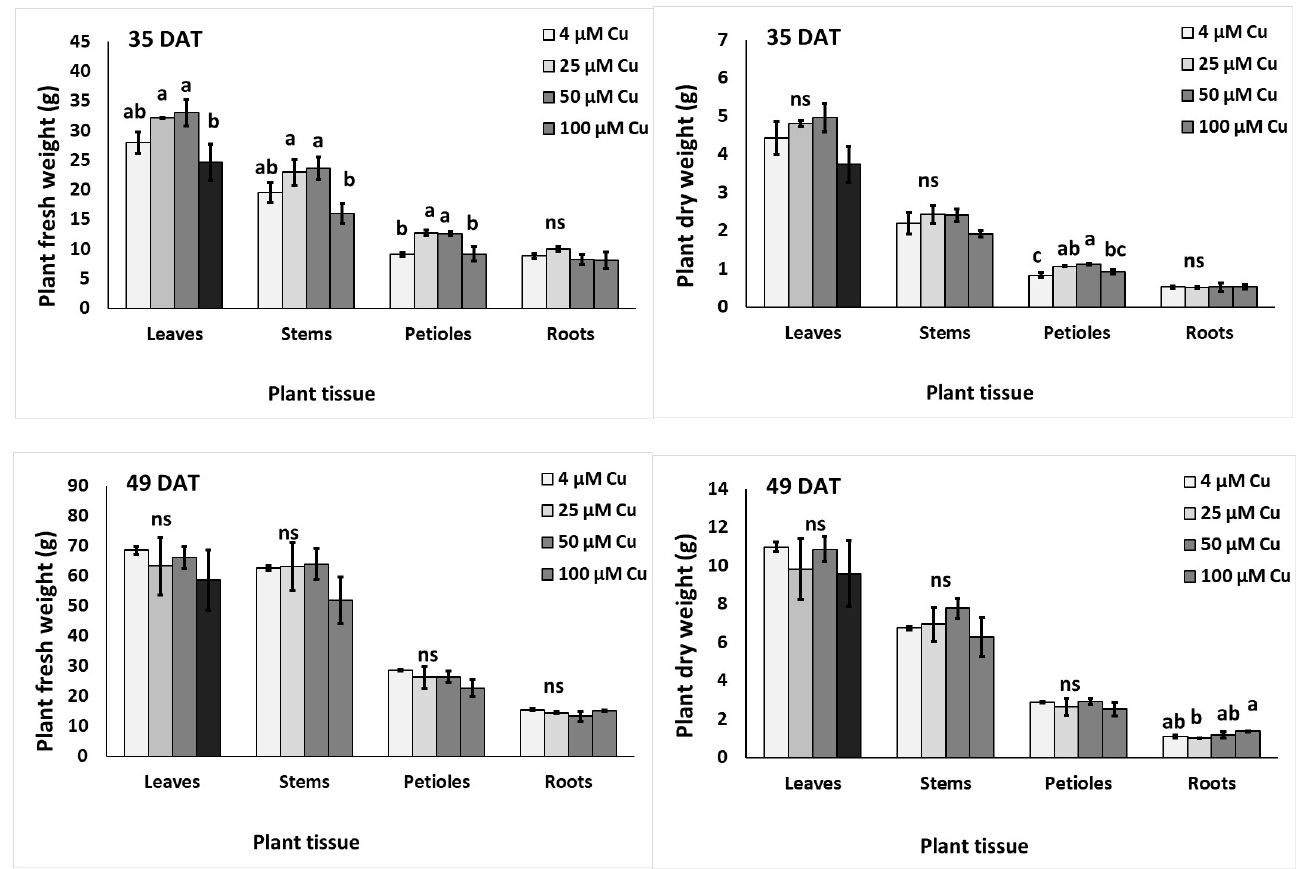
Figure 1. Effect of increasing copper (Cu) concentration (4–25–50–100 µ M Cu 2+ ) in the nutrient solution and sampling date after transplanting (DAT, 35 days and 49 days) on the fresh (FW; g plant − 1 ) and dry weight (DW; g plant − 1 ) of leaves, stems, petioles and roots respectively, of pelargonium plants grown hydroponically in perlite. Significant differences ( p < 0.05) among Cu concentrations for each plant tissue are indicated by different letters; ns indicates non-significant. Error bars show SE ( n = 6).